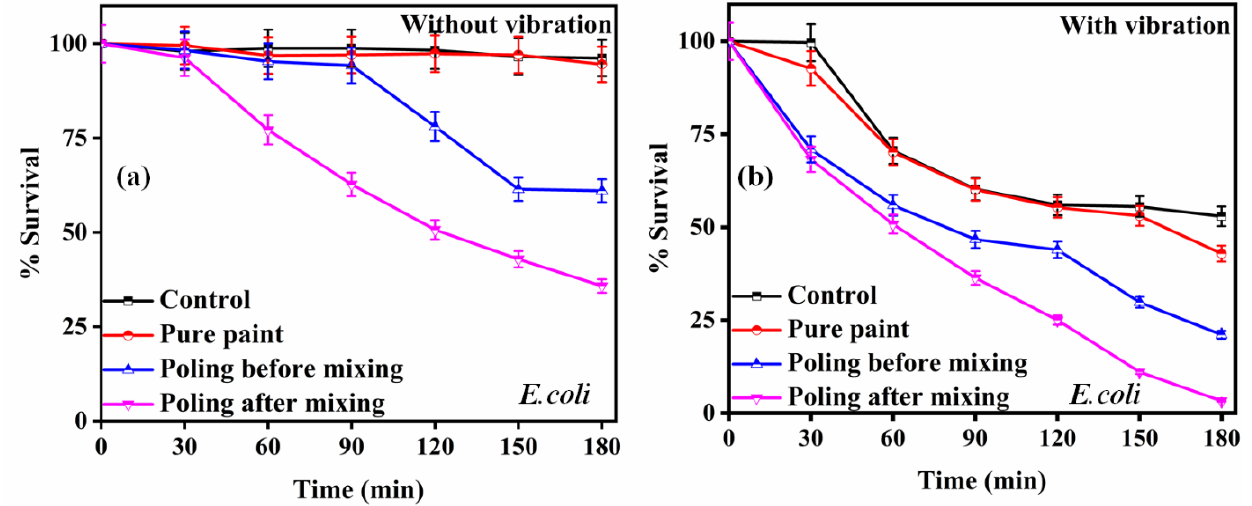
Figure 6. ( a , b ) Survival percentage of E. coli bacteria cell colonies under different conditions.